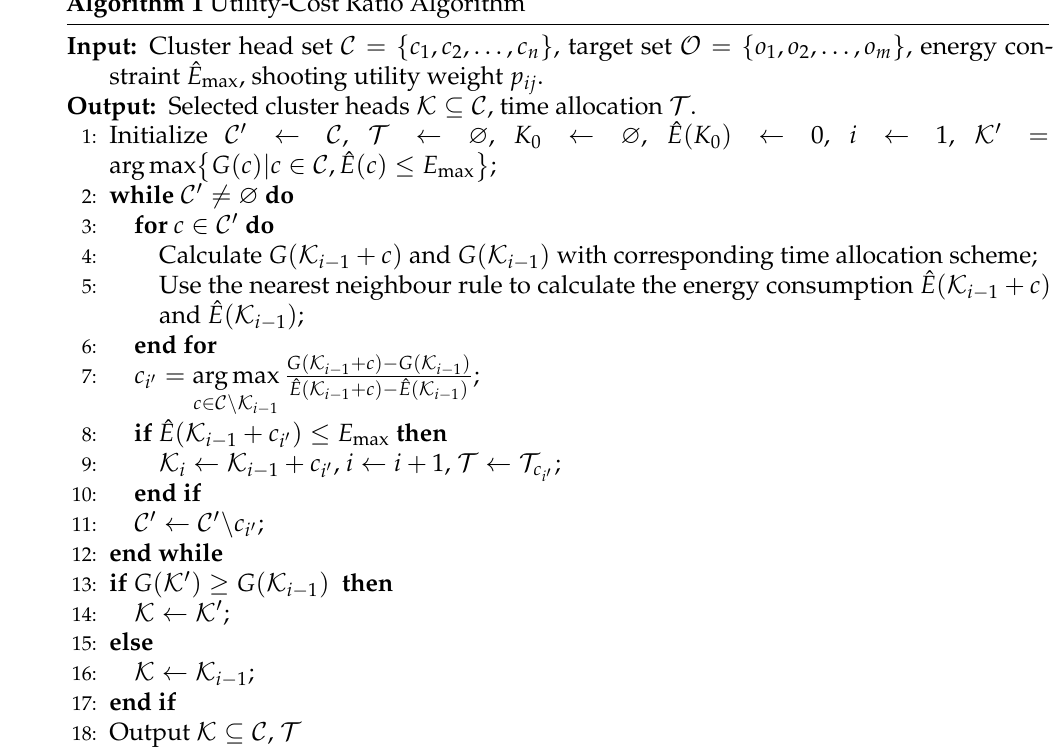
Algorithm 1 Utility-Cost Ratio